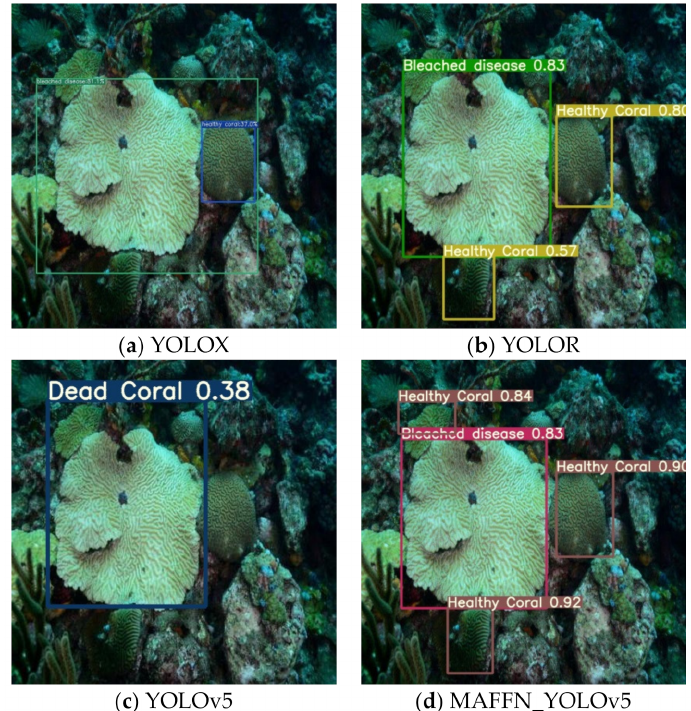
Figure 28. Multiple and missed detections.